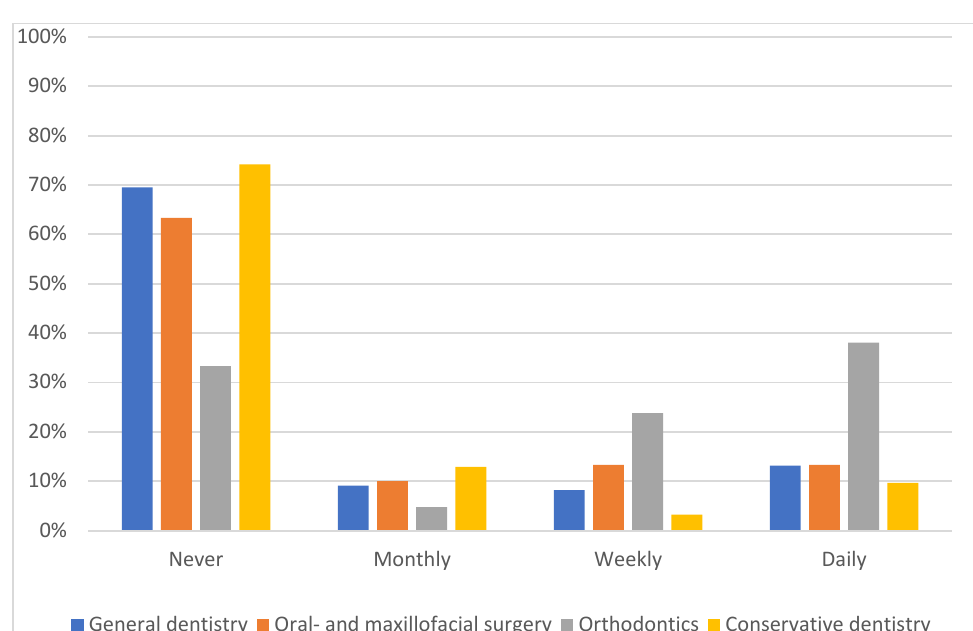
Figure 2. Self-reported frequency of the use of AI in clinical practice.